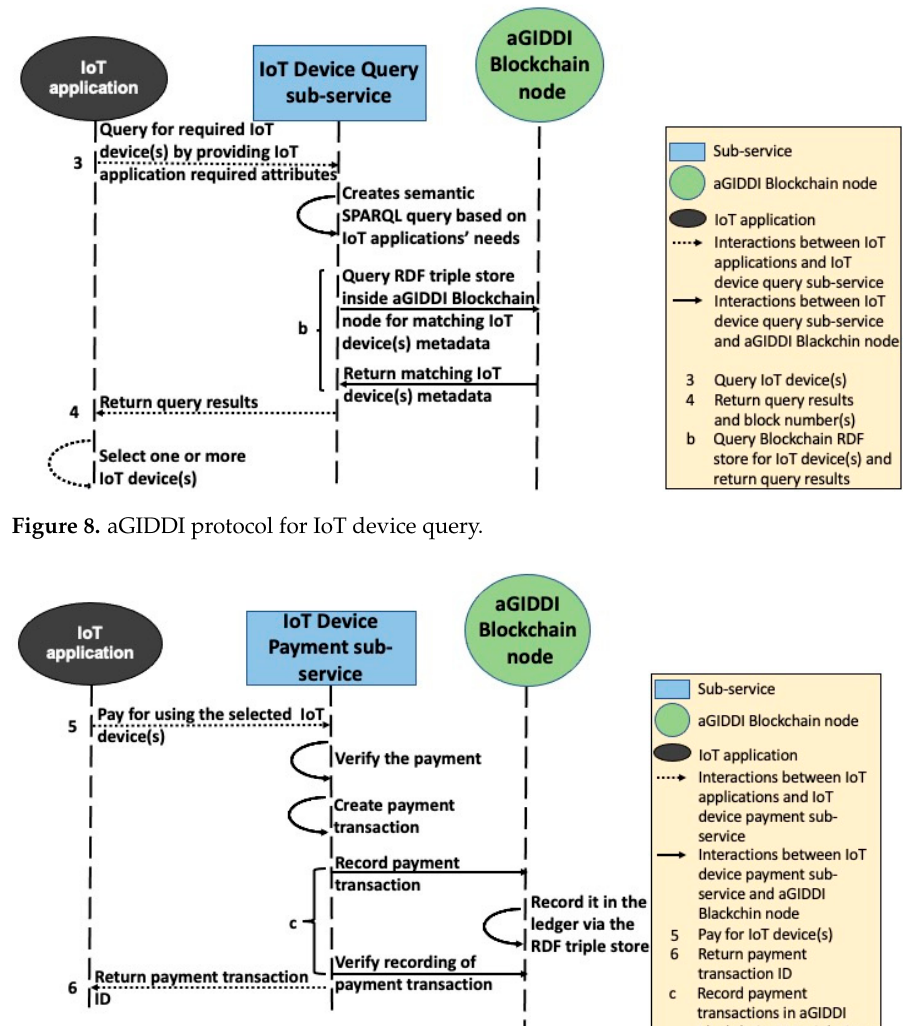
Figure 8. aGIDDI protocol for IoT device query.